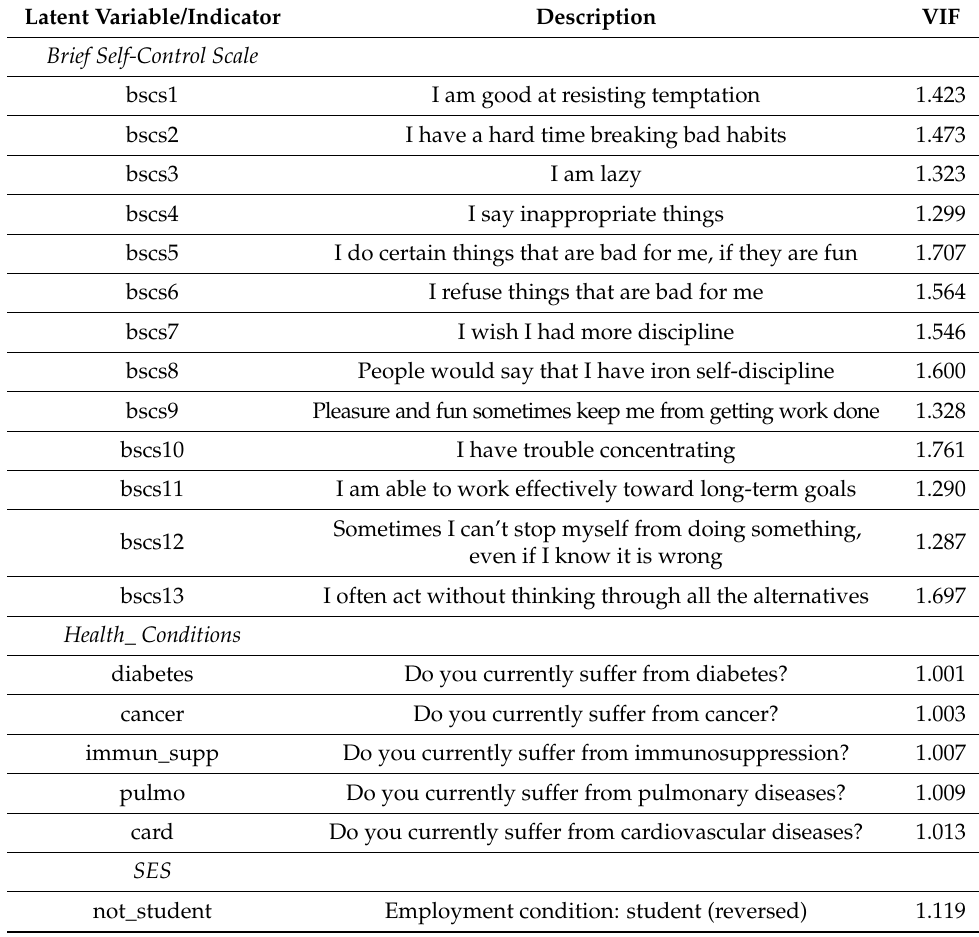
Table A1. Variable names, Descriptions and Variance Inflation